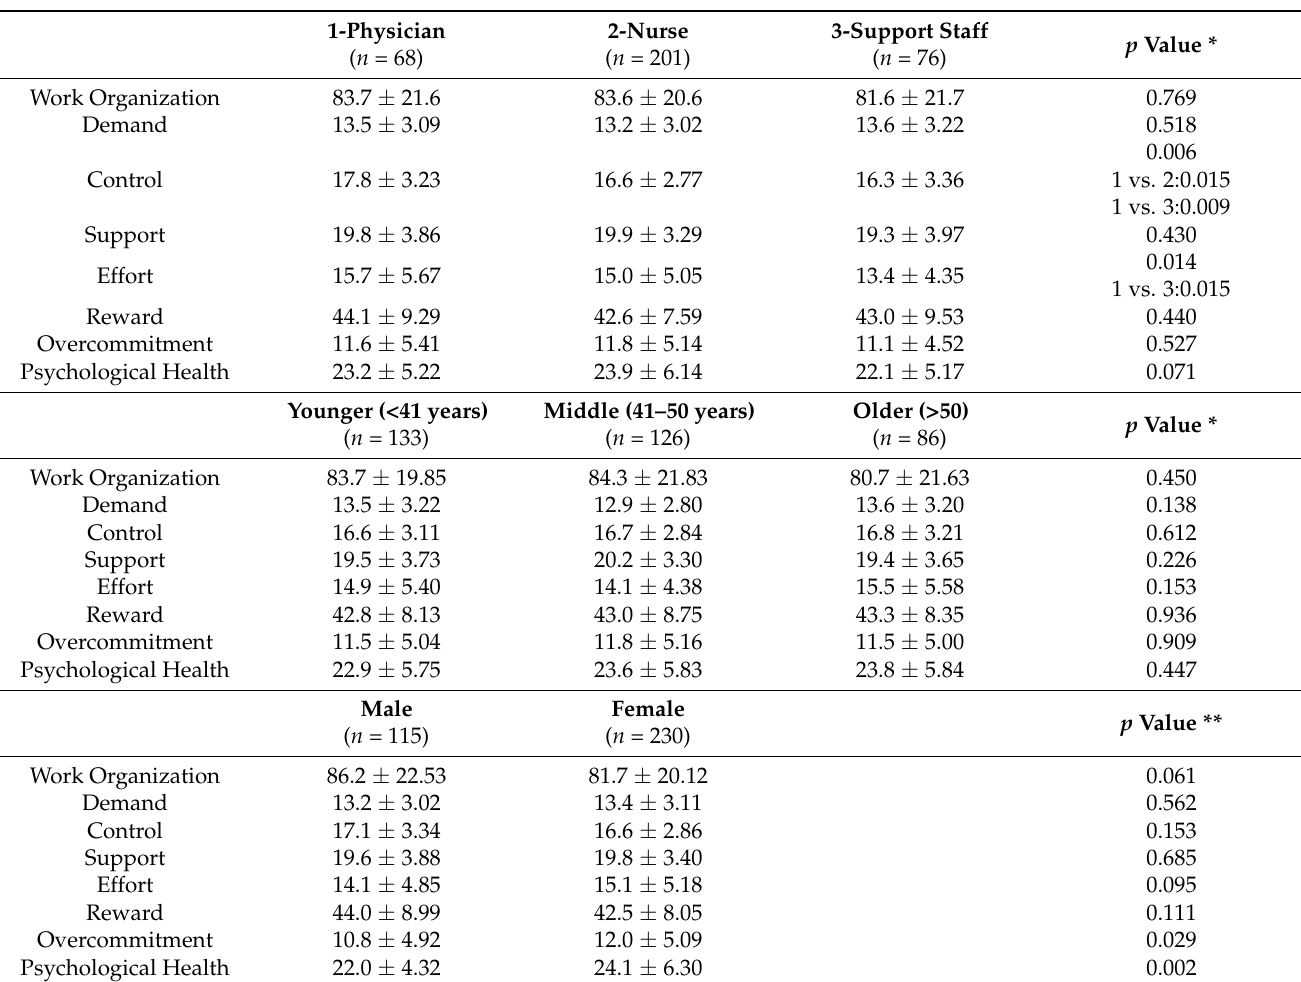
Table 2. Distribution of work organization assessment (WOAQ score, mean ± standard deviation), occupational stress (DCS and ERI) and psychological health (GHQ12) by occupational group, gender, and age group.